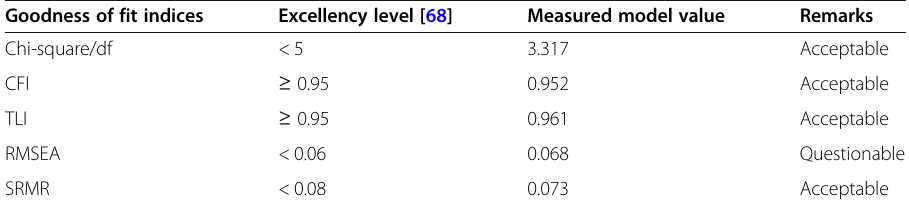
Table 6 Model fit results and acceptable thresholds of the model fit indices Goodness of fit